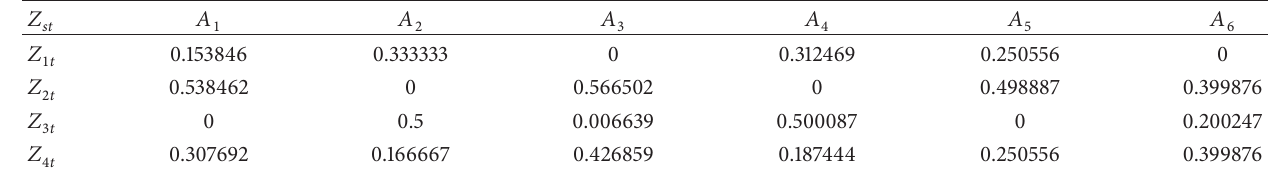
Table 6: The normalized nearness degree of every index vector.